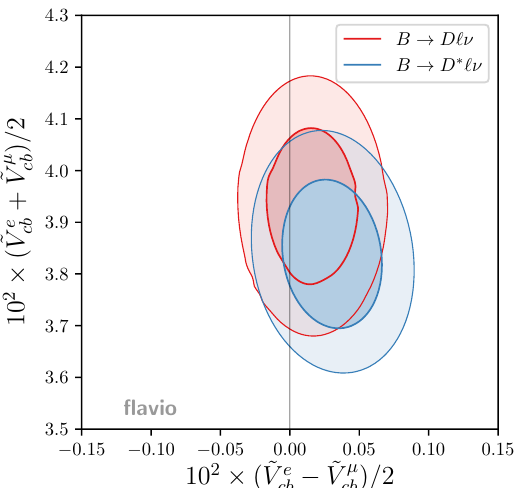
Figure 3 . Constraints on LFU violation in the left-handed vector current from exclusive decays. The vertical line corresponds to the LFU